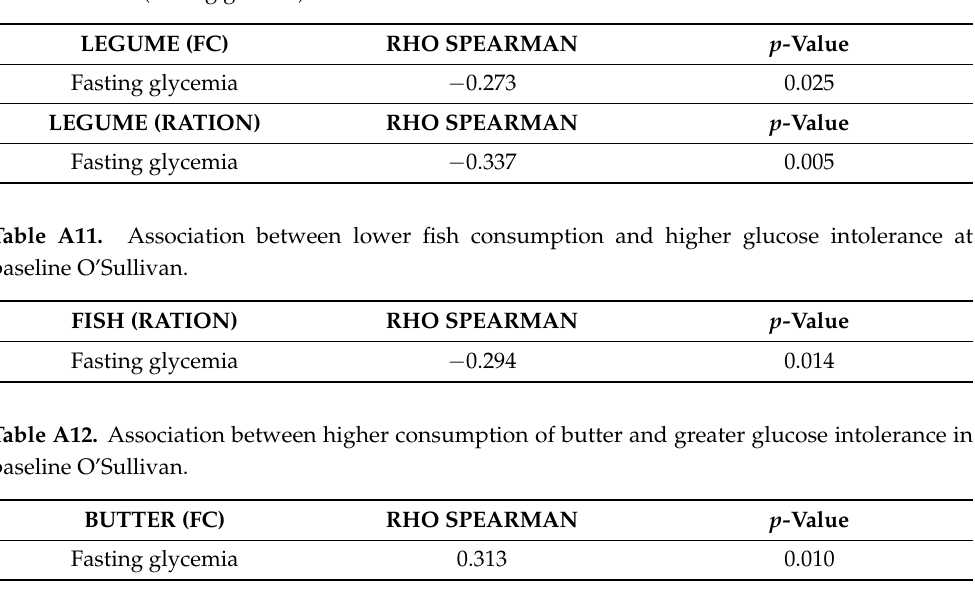
Table A10. Association between a low consumption of legumes and glucose intolerance in the O’Sullivan test (fasting glucose).